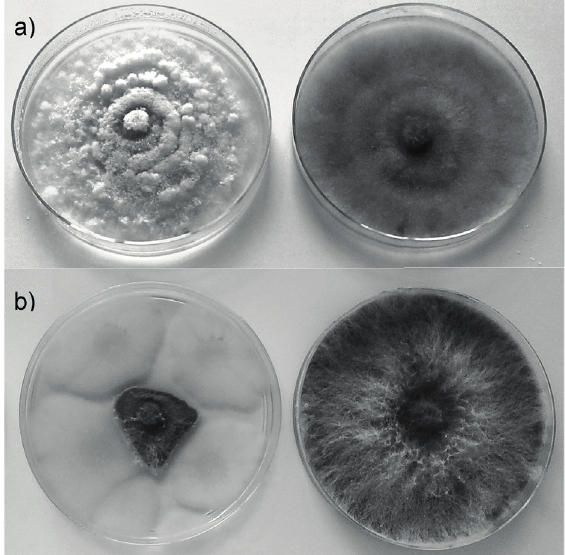
Figure 1. Mycelial growth of F. oxysporum isolate FusTD901, on the 14 th day of growth, in the antagonism assay of B. subtilis F62 by volatile compounds (a) and by diffusible compounds/dual culture (b). The control is on the right side in both